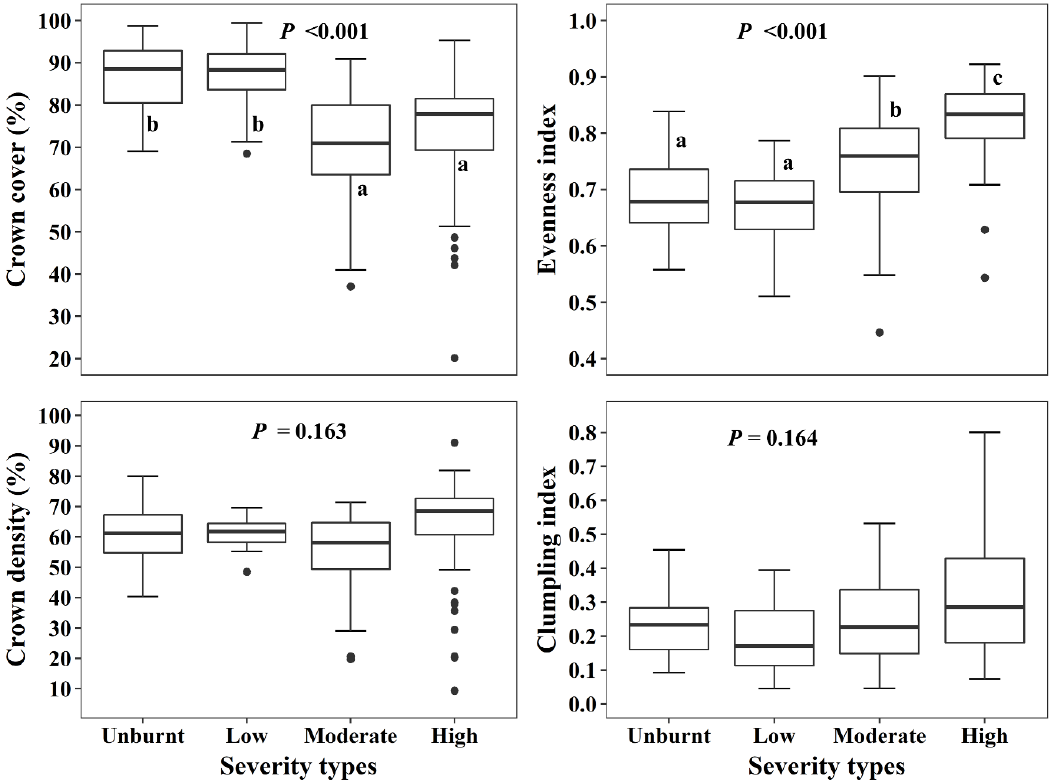
Figure 7. Comparison of LiDAR-derived crown metrics — crown cover, crown density, evenness index and clumping index — among fire-severity types for trees delineated in the LiDAR data. Graphs are standard boxplots (median as centre line), based on 41 to 60 trees per severity type (UB — 41, L — 43, M — 52, H — 60). P-values are from LMEM, and different letters indicate significant differences between fire-severity types as indicated by post hoc tests (Fisher’s LSD test).